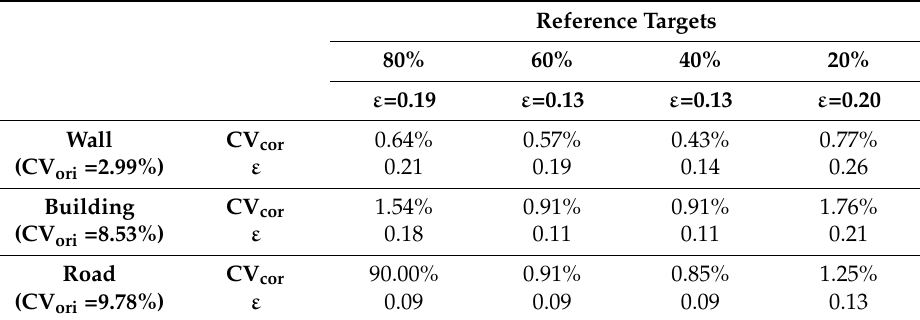
Figure 8. Relatively corrected intensity values of the sampled regions of the three surfaces. ( a ) The 80% target is used as a reference; ( b ) The 60% target is used as a reference; ( c ) The 40% target is used as a reference; ( d ) The 20% target is used as a reference. Table 6. Relative correction results of the three surfaces when different reference targets are